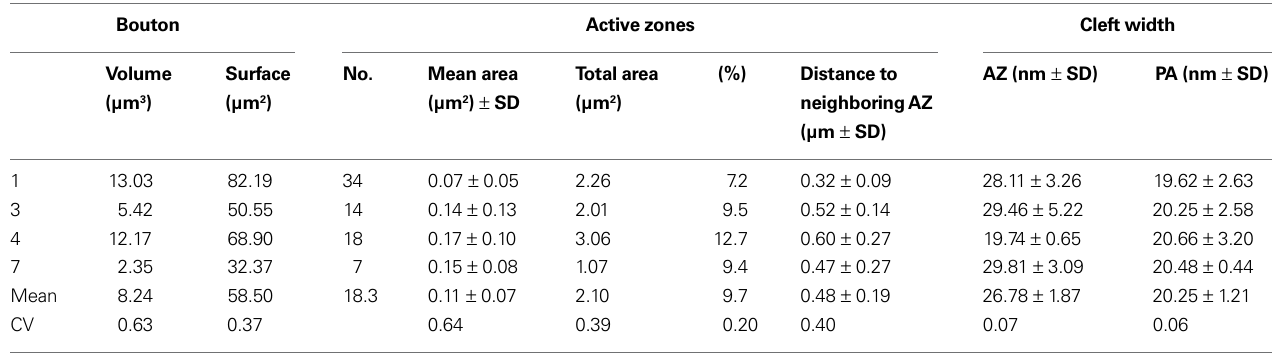
Table 1 | Quantitative analysis of structural elements of adult MFBs.